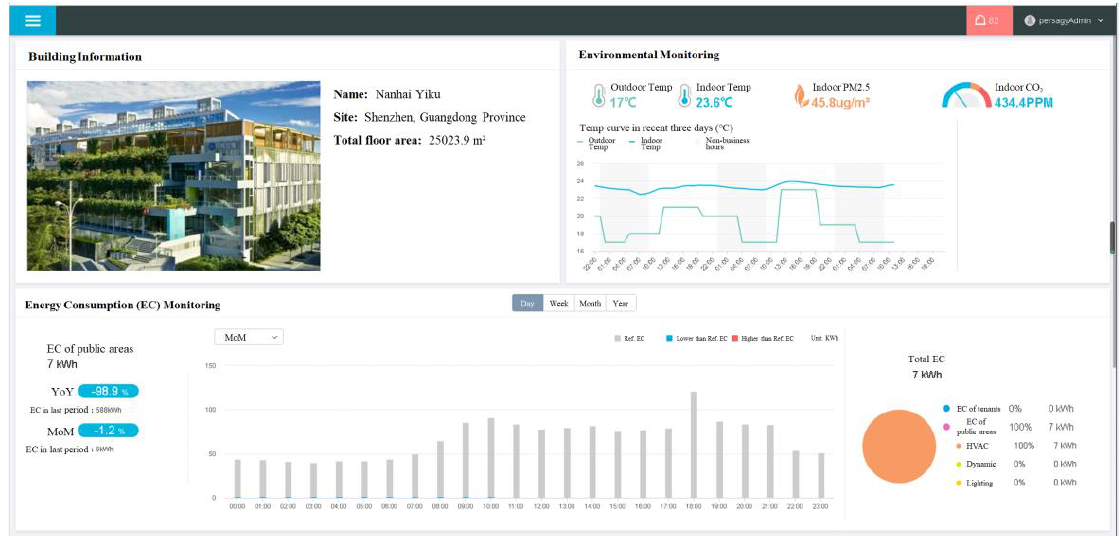
Figure 6. The energy management system of the green